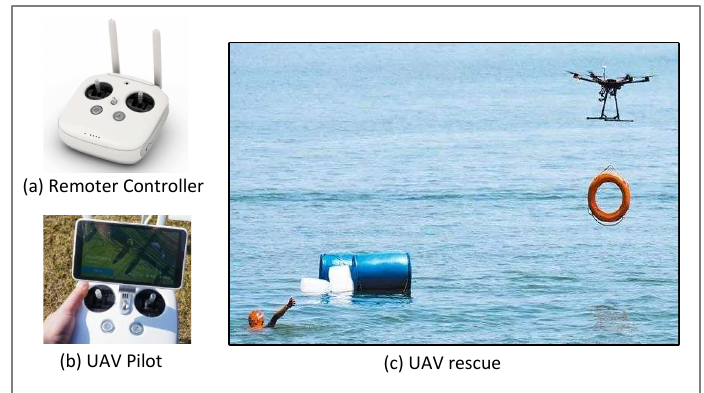
Figure 2. Human-UAV interaction is more than flying a UAV (like ( a , b ). In the case of UAV rescue ( c ), the UAV needs to understand the action of person who needs to be